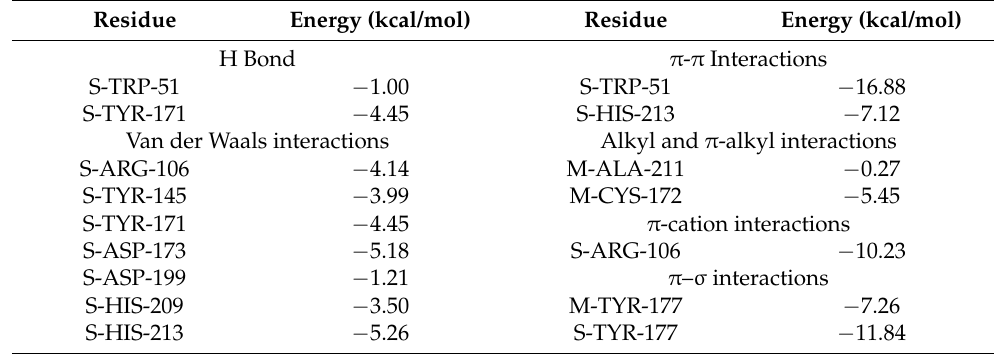
Table 6. The energies of the main interactions between compound 3 and endoglucanase I (pdb ID: